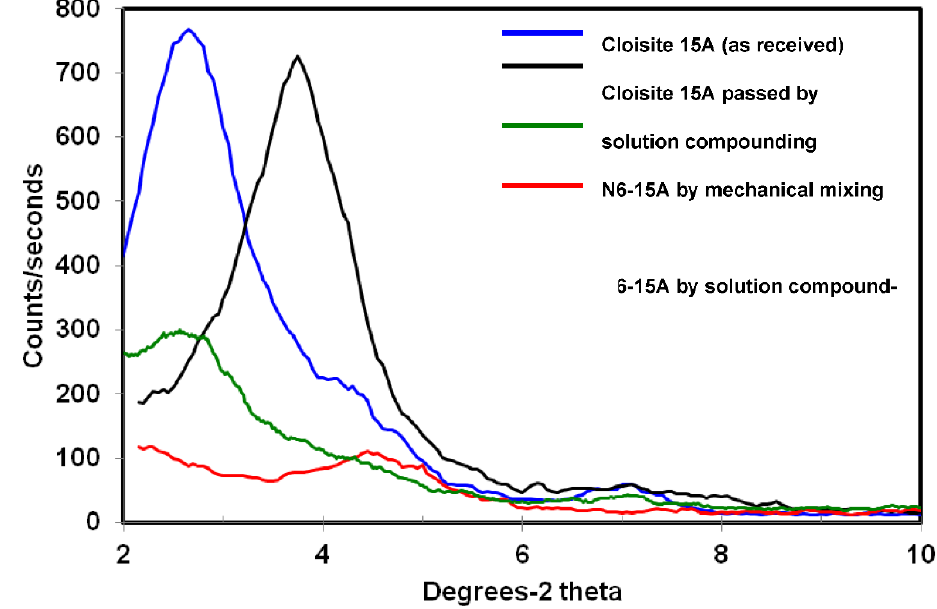
Figure 2. XRD diffraction patterns for the different 15A and 15A composite samples.